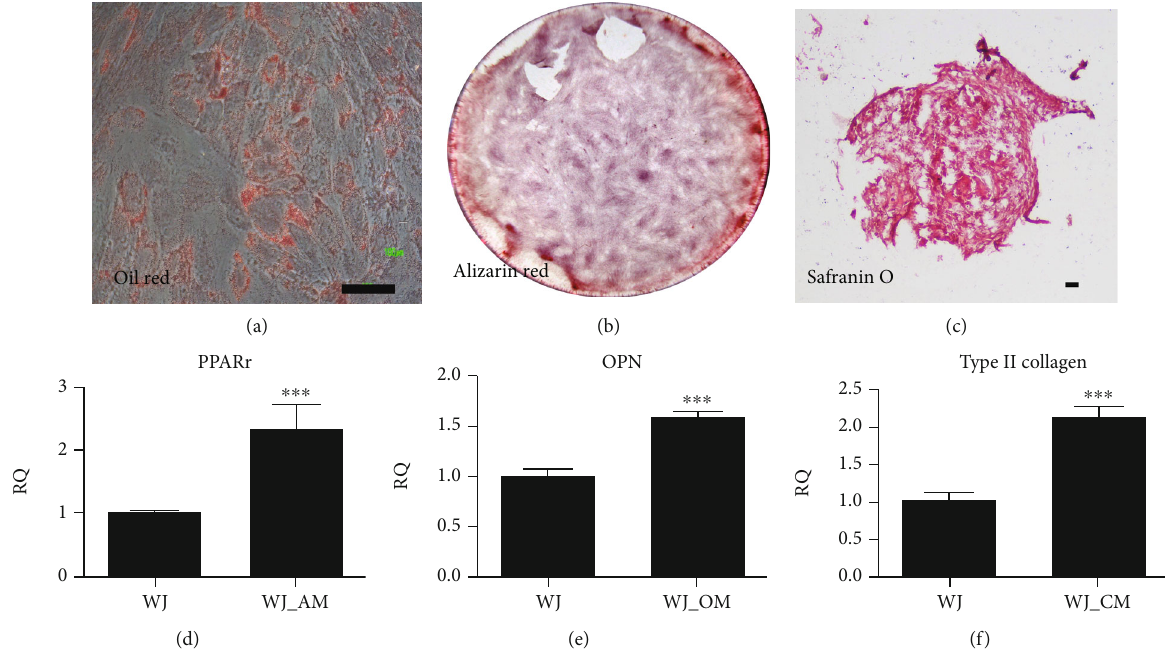
Figure 2: Three lineage di ff erentiation of HUCMSCs. (a) Adipogenesis is for 2 weeks and is demonstrated by Oil red staining. Scale bar = 100 μ m . (b) Osteogenesis is for 2 weeks and is demonstrated by Alizarin red staining. (c) Chondrogenesis is for 3 weeks and is demonstrated by Safranin O staining. Scale bar = 100 μ m . (d – f) qPCR analysis of gene expression of three lineages: adipogenesis ( PPARr ), osteogenesis ( osteopontin ( OPN )), and chondrogenesis ( type II collagen ). ∗∗∗ p < 0 : 001